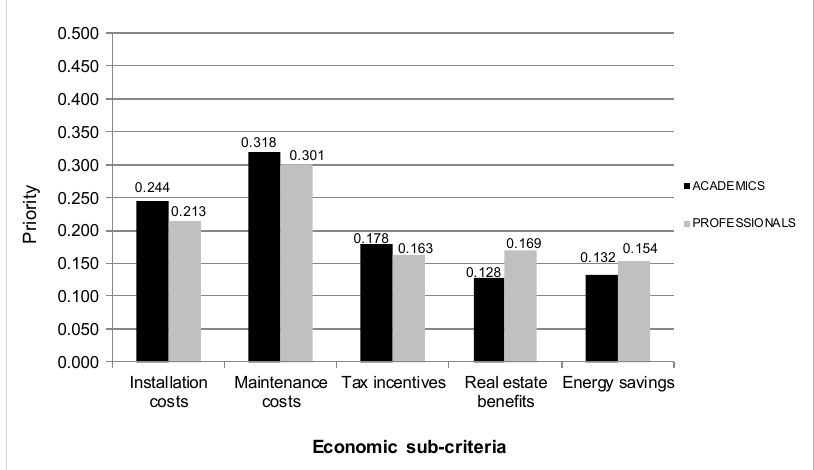
Figure 4. Priorities assigned to “Economic” sub-criteria by Academics and Professionals.